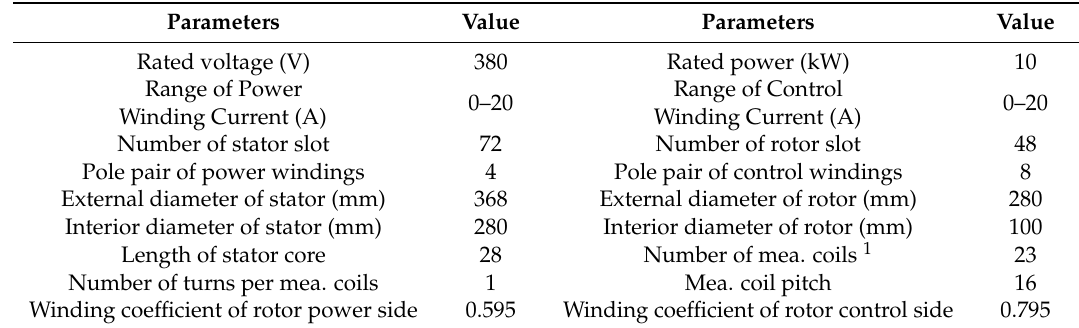
Table 1. Configuration parameters of experimental wound-rotor BDFM.